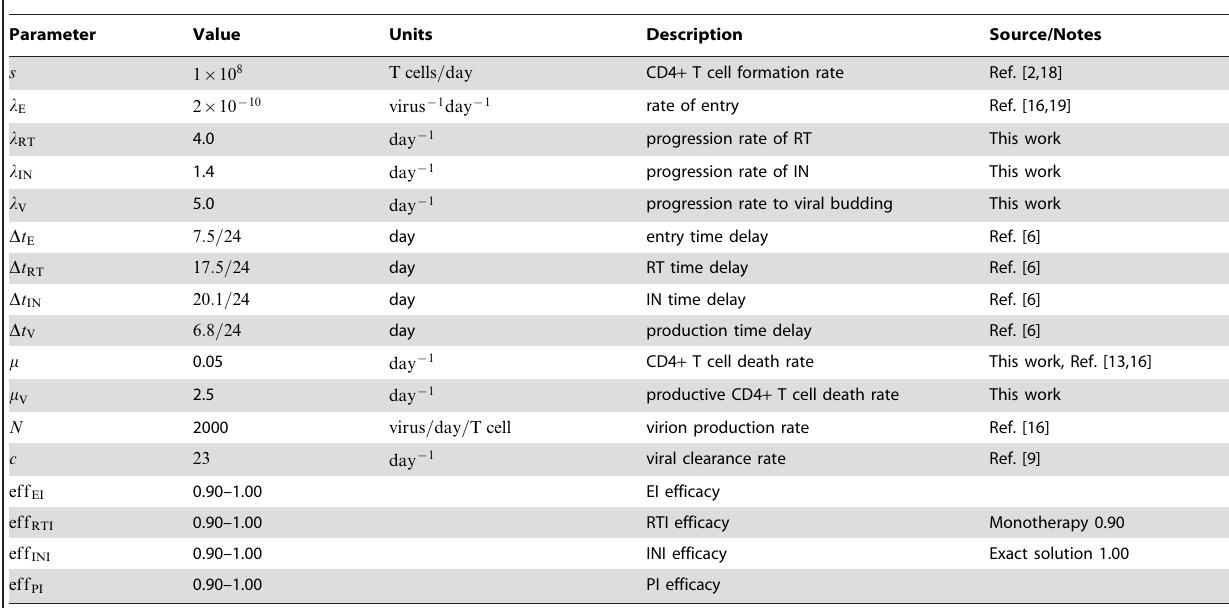
Table 1. Summary of model parameters.